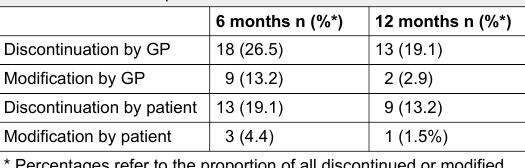
Table 2: Discontinuation and modification of evidence-based secondary preventive medication by general practitioners and patients. Overall, 53 medications were discontinued and 15 were modified in 52 of 204 patients.